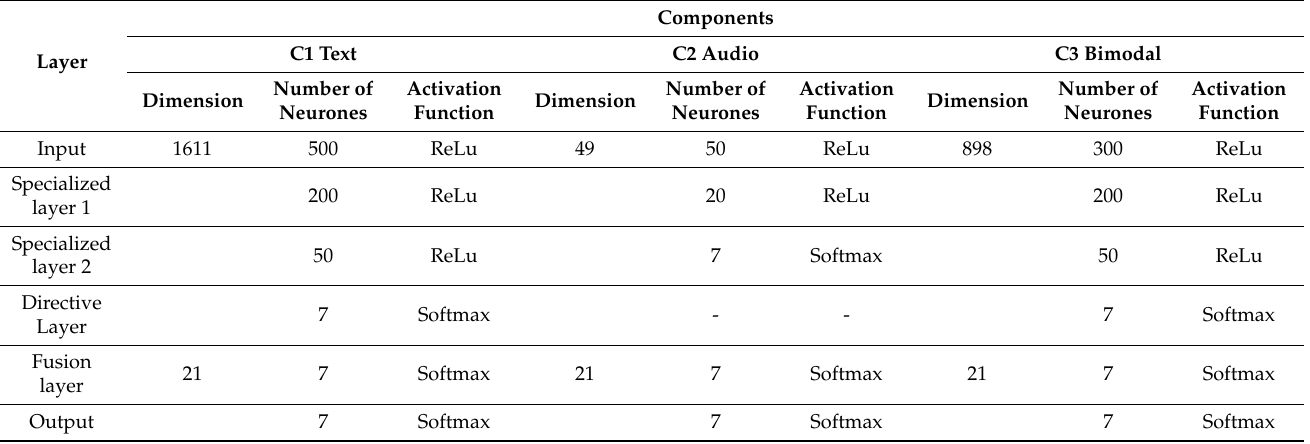
Table 1. Classification parameters.